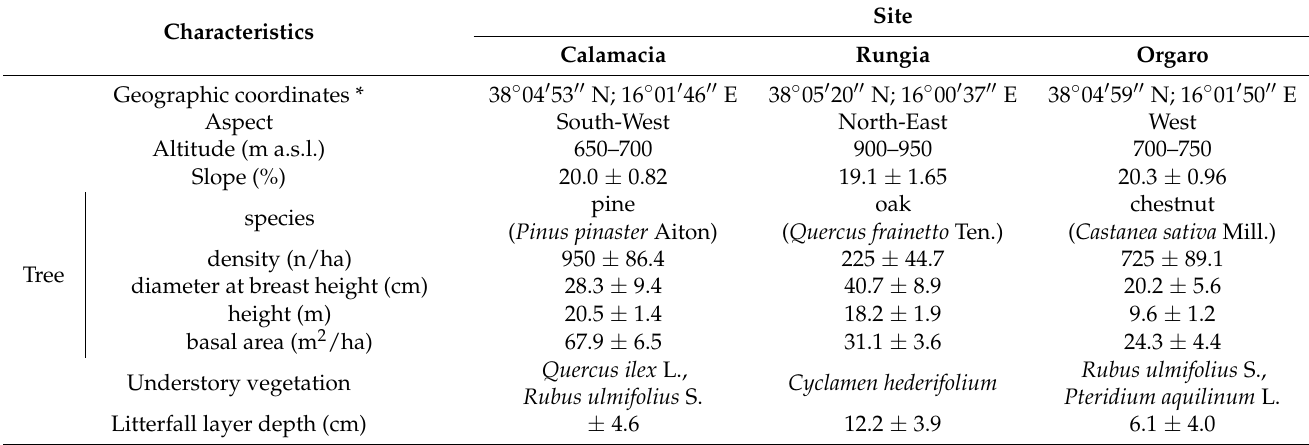
Table 1. Main characteristics of the experimental forest sites (Samo, Calabria, Southern Italy).